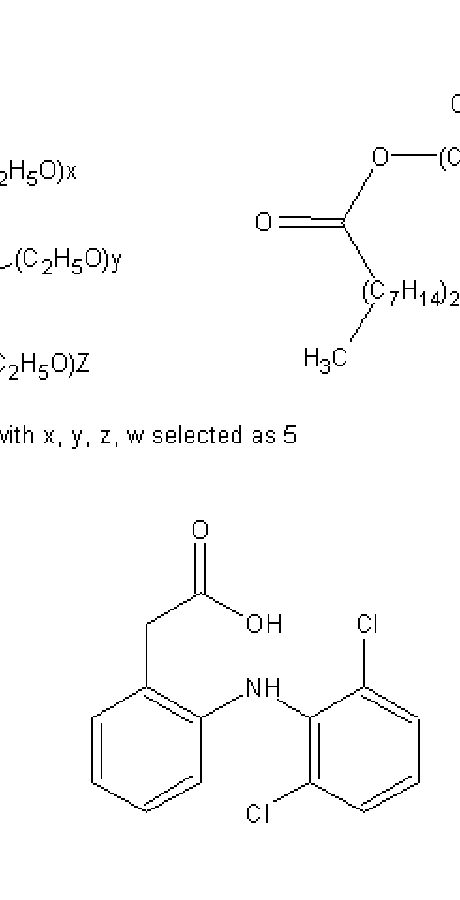
Figure 1. Chemical structure of oleyl palmitate, Tween80, and Diclofenac